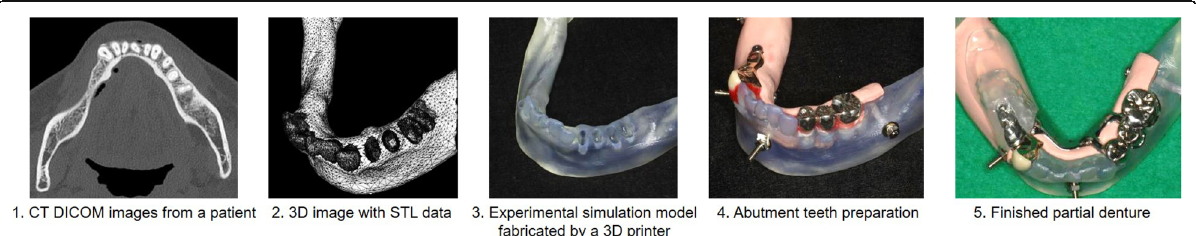
Fig. 1 Fabrication process of the resin mandibular model for mechanical simulation and denture